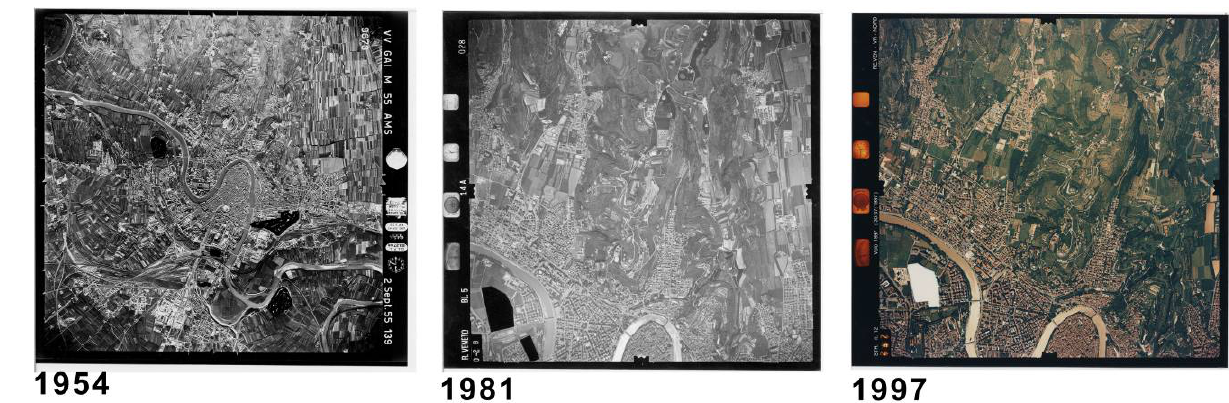
Figure 1: sample images of the time series: 1954, 1981,